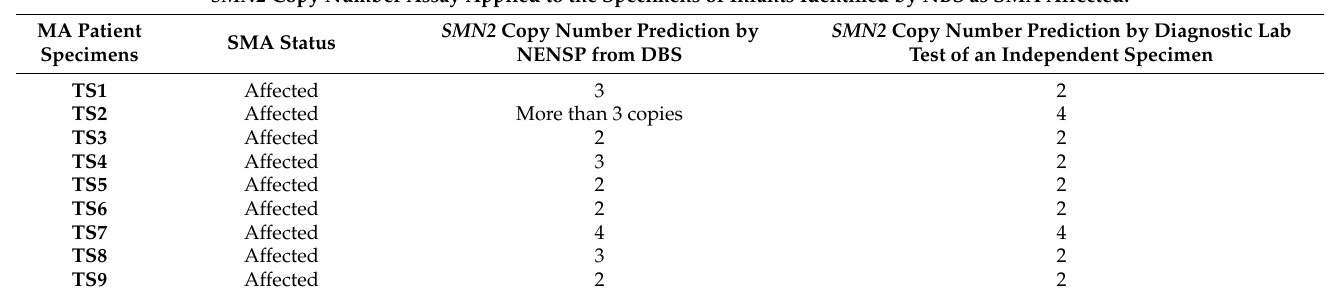
Table 2. Comparison of SMN2 copy numbers in newly diagnosed infants generated by our modified sequencing assay and by diagnostic